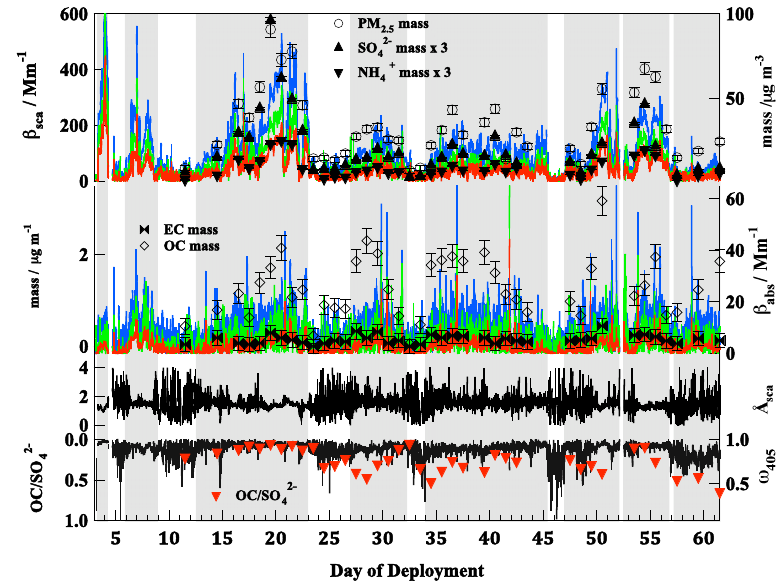
B. A. Flowers et al.: Optical-chemical-microphysical relationships and closure studies Figure 1. 736